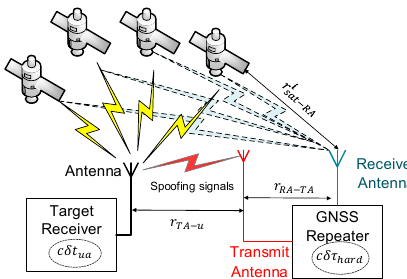
Figure 1. A schema of transmitter-based spoofing